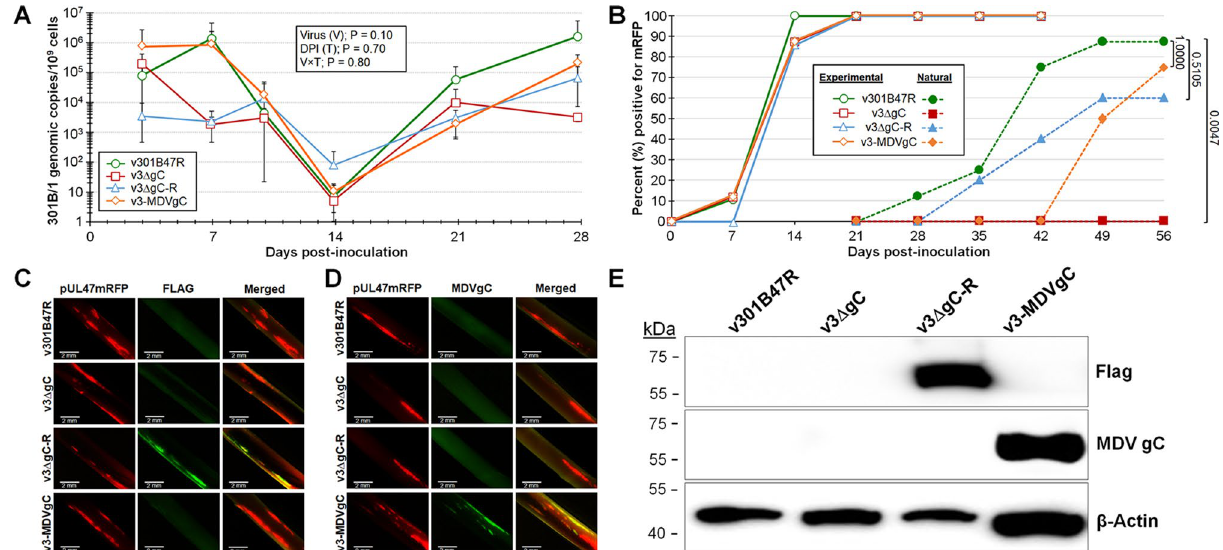
Figure 4. Replication and interindividual spread of r301B/1 viruses in chickens. Pure Columbian chickens were experimentally infected with v301B47R, v3ΔgC, v3ΔgC-R, or v3-MDVgC as described in the Materials and Methods for 56 days. ( A ) Replication was monitored in experimentally infected chickens by quantification of 301B/1 genomes in the blood over the first 4 weeks of infection. Shown is the mean 301B/1 genomic copies per 10 6 blood cells ± standard error of means. No significant differences ( p > 0.05, n = 109) were determined between all viruses at the same time point. ( B ) Quantitative analysis of the percent of birds positive for pUL47mRFP in FFs over the course of the experiment. Using Fisher’s exact test at p < 0.05, there was no significant difference in the total number of chickens positive for experimentally infected chickens with 100% positive by 21 days pi. No naïve contact chickens housed with v3ΔgC were naturally infected, while 88, 75, and 60% of contact chickens were naturally infected with v301B47R, v3-MDVgC, or vΔgC-R, respectively. Using Fisher’s exact test at p < 0.05, there was no significant difference between v3ΔgC-R ( p = 0.5105) and v3-MDVgC ( p = 1.0000) compared to v301B47R, while v3ΔgC was significantly different ( p = 0.0047). ( C and D ) Feathers were plucked from v301B47R, v3ΔgC, v3ΔgC-R, and v3-MDVgC at 28 dpi, fixed, then stained using anti-Flag M2 ( C ) or anti- MDV gC ( D ) antibodies. FFs obtained from v3ΔgC-R-infected birds were positive for 3 × Flag301B gC, while FFs from v3-MDVgC -infected chickens were positive for MDV gC protein. ( E ) Western blot analysis for 3 × Flag301B and MDV gC in FFEs. Whole-cell protein lysates were collected from FFE cells scraped from infected FFs, electrophoresed through a 10% SDS-PAGE gel, transferred to nitrocellulose membranes, and probed for Flag or MDV gC as described in the Materials and Methods. Anti-β-actin antibody was used as internal cellular virus and the addition of a 3 × Flag epitope at the N-terminus did not affect its function during transmission. We were also able to conclude that MDV gC can compensate 301B/1 gC during interindividual spread of 301B/1 virus. This data, combined with our former work on MDV 15,16 , suggests the essential role for the alphaherpesvirus conserved gC during interindividual spread is a conserved function of avian herpesviruses. The exact role of MDV and 301B/1 gC during interindividual spread is not completely understood, but the absolute requirement during natural infection suggests it may be involved in virus-cell binding to cells. Homologs of gC perform multiple functions in vitro that include primary attachment of cell-free virus to proteoglycans on the surface of cells 2,3,34,35 but is not required for specific interactions on cells where glycoprotein (gD) nor- mally performs this function 36,37 . For HSV-1, gD binds to the herpesvirus entry mediator (HVEM), nectin-1, nectin-2, or modified heparin sulfate on the surface of cells providing a mechanism for cell tropic binding 38 and